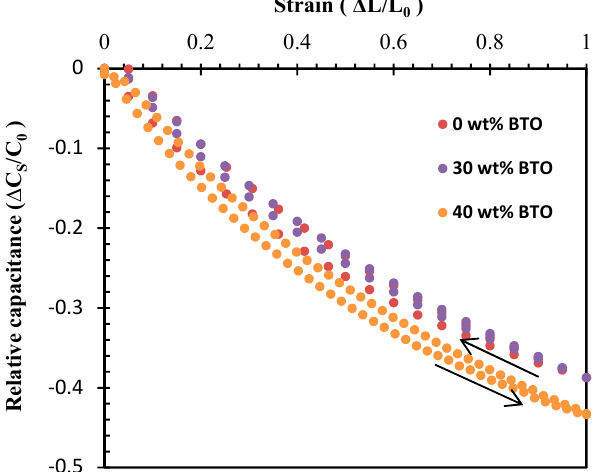
Figure 8. The change in capacitance (C S ) versus strain of the IDC sensors made from 0 wt%, 30 wt%, and 40 wt% BTO.